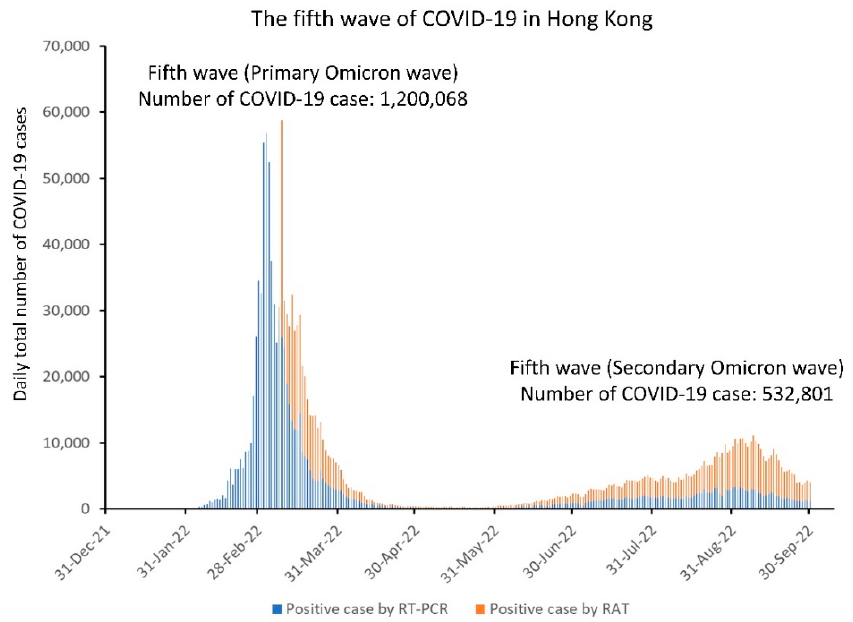
Figure 3. Epidemic curve of the fifth wave of COVID-19 in Hong Kong. RT-PCR, reverse-transcription–real-time polymerase chain reaction; RAT, rapid antigen test.